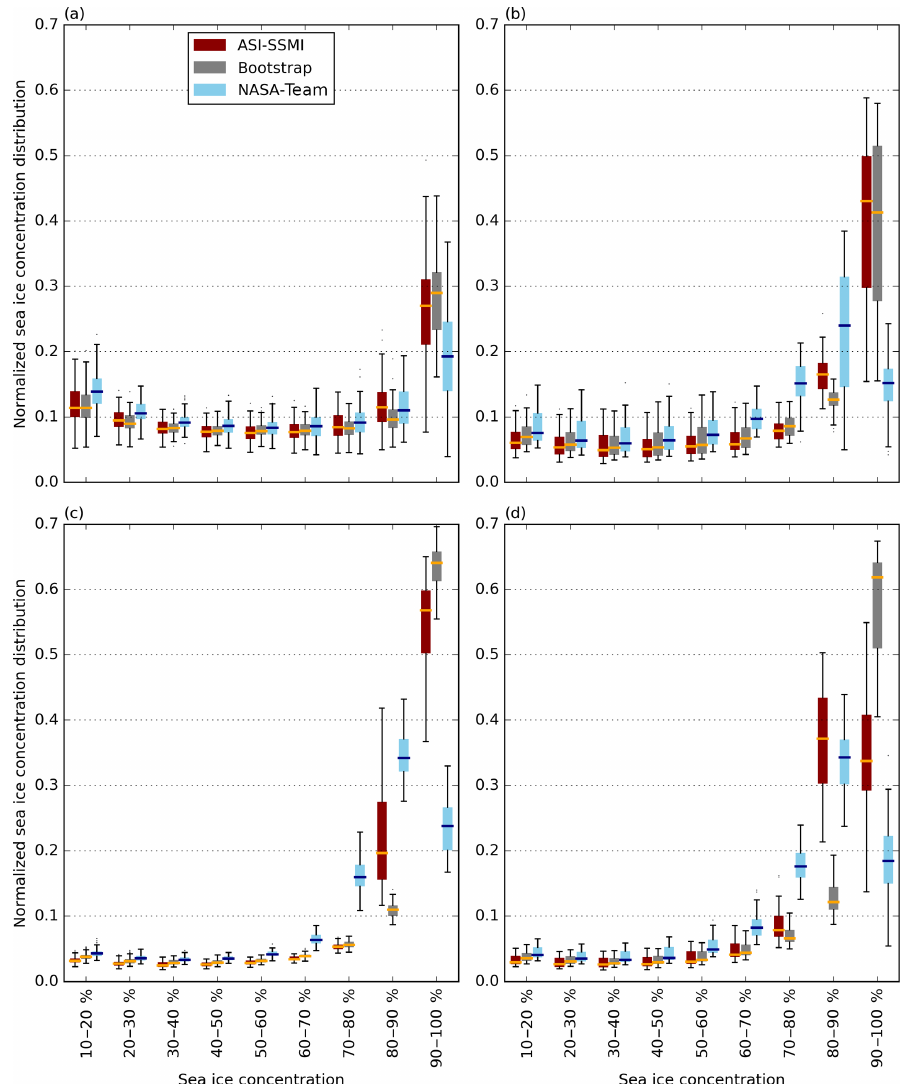
Figure 4. The normalized sea ice concentration distribution for all months in each year from 1992 to 2014 in (a) DJF, (b) MAM, (c) JJA, and (d) SON from the three sets of satellite observations. Box plots as in Fig.